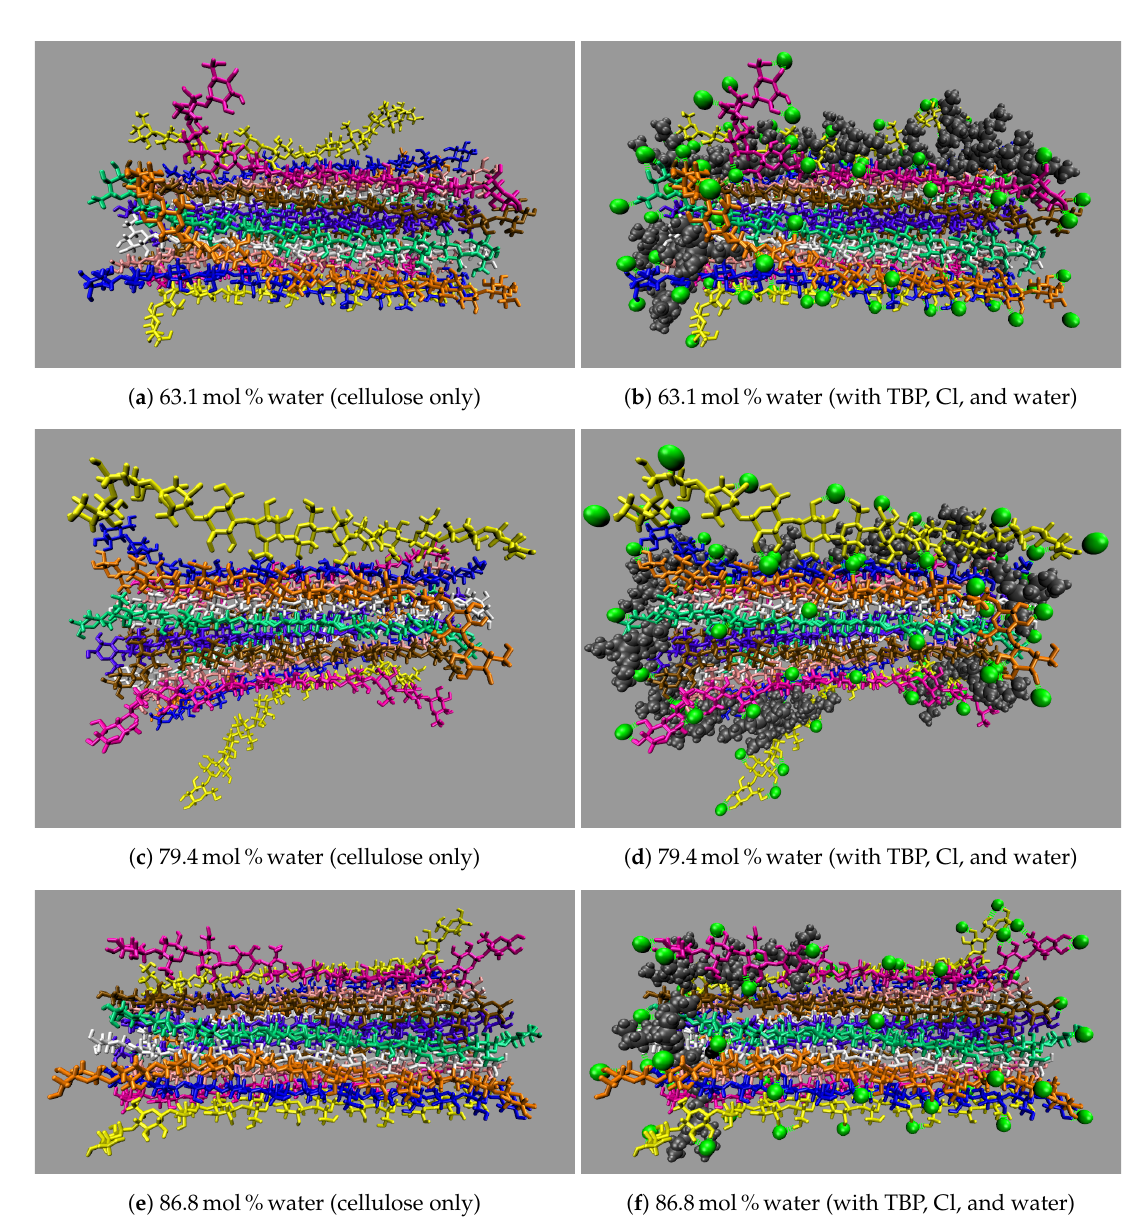
Figure A9. Side view images of the cellulose bundle dissolution at 600ns, showing all the nearby TBP, Cl, and water molecules as described earlier (Part 1 of 2) at: ( a ) 63.1mol%water (cellulose only); ( b ) 63.1mol%water (with TBP, Cl, and water); ( c ) 79.4mol%water (cellulose only); ( d ) 79.4mol%water (with TBP, Cl, and water); ( e ) 86.8mol%water (cellulose only); and ( f ) 86.8mol%water (with TBP, Cl, and